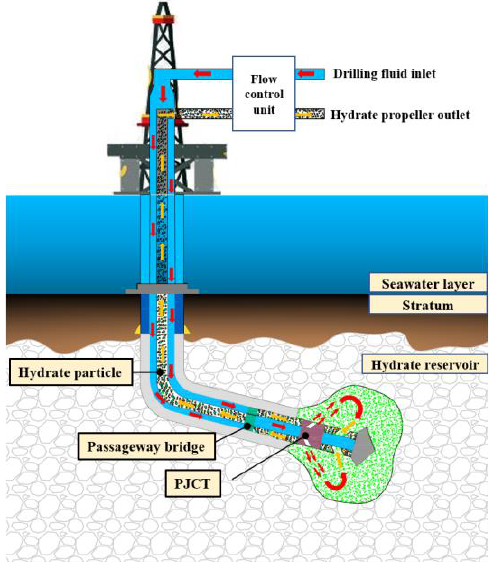
Figure 1. Solid fluidization exploitation of NGH.